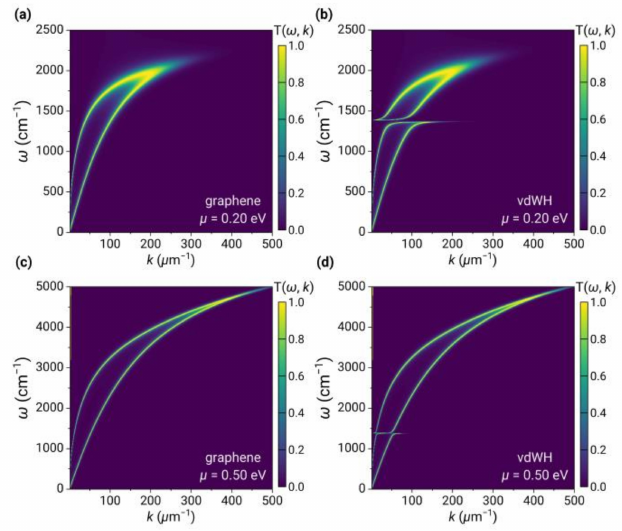
Figure 4. Energy transmission coefficient T ( ω , k ; d ) for graphene (left panels) and 2D vdW het- erostructures (right panels) at chemical potentials of ( a , b ) 0.2 eV and ( c , d ) 0.5